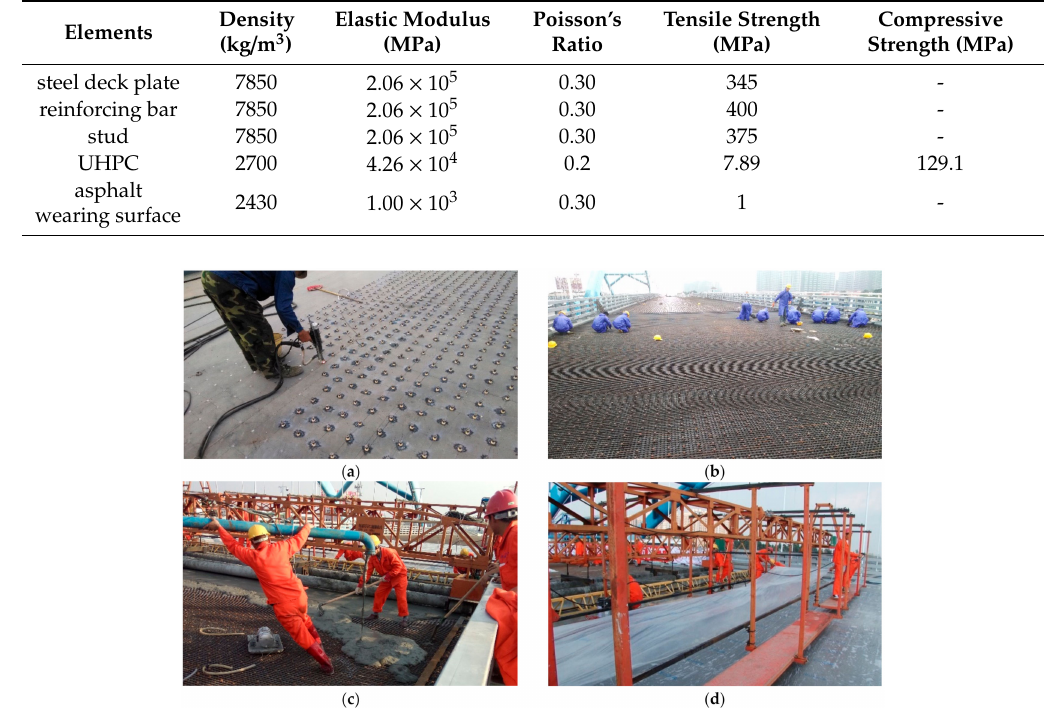
Figure 4. Construction process of UHPC layer of composite OSD: ( a ) Stud welding; ( b ) Reinforcing bar fixing; ( c ) UHPC casting; ( d ) UHPC moist curing.